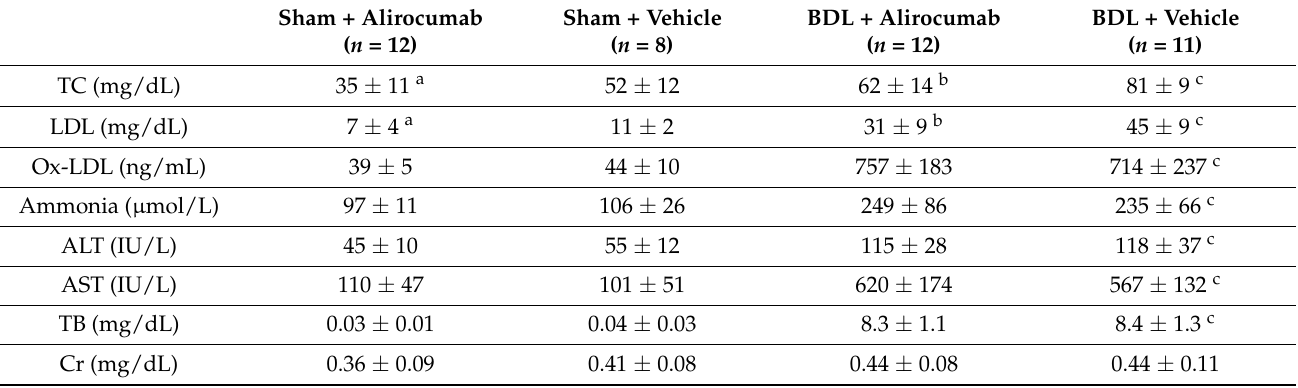
Table 2. Biochemistry parameters of sham-operated or BDL rats with or without alirocumab treatment. Sham + Alirocumab